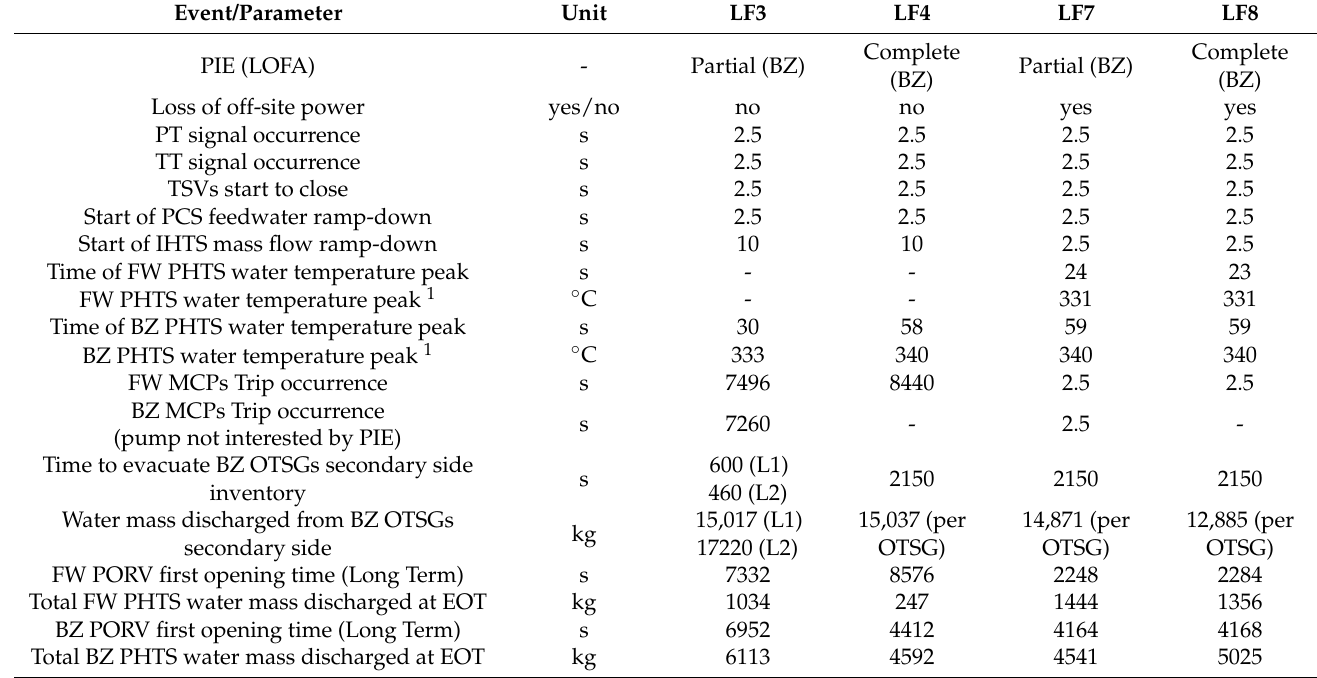
Table 8. Summary table for LOFA transients involving BZ PHTS